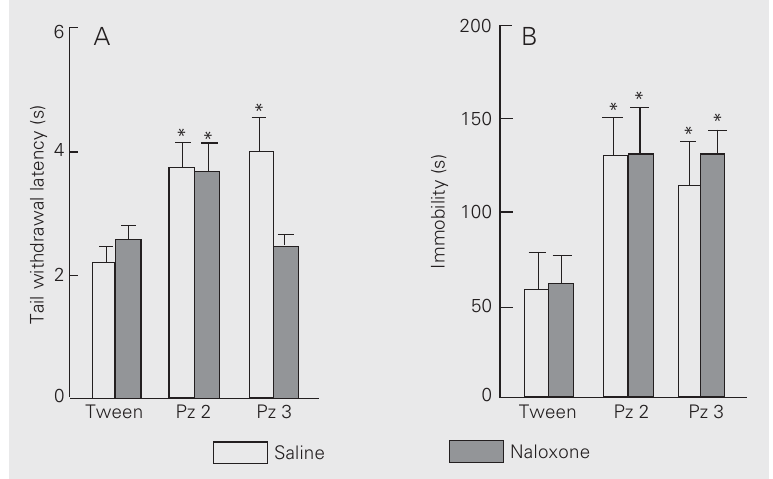
Figure 4. Effect of naloxone on the antinociception (A) and immobility (B) induced by Pz 2 and Pz 3. Naloxone (2.75 µmol/kg) and Pz 2 and 3 (1.5 mmol/kg) were injected sc . Data are reported as means ± SEM for N = 7-9 animals per group. *P < 0.05 compared with vehicle (Tween) group (Student-Newman-Keuls